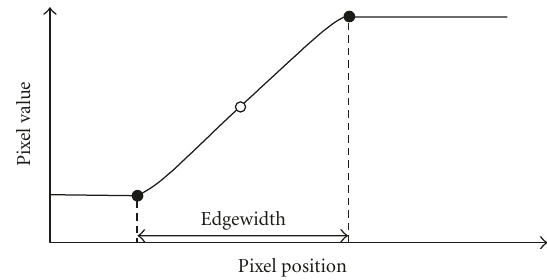
Figure 5: Definition of edgewidth, where a white circle represents an edge position and black circles denote end positions of the